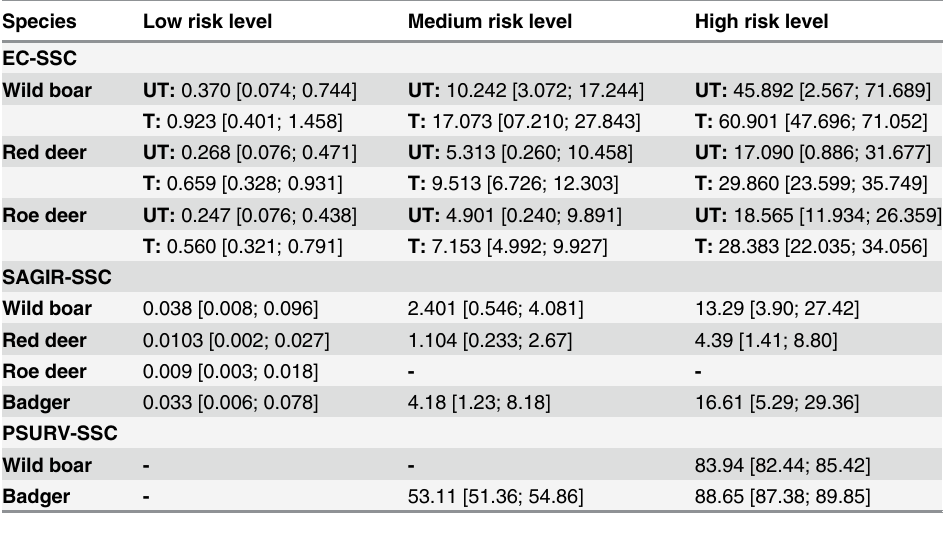
Table 8. Component sensitivity (CSe) for each SSC of the Sylvatub system, by species, age class, geographic risk, for 100 animals processed by the SSC, by species and risk level (percentage, mean [CI 95